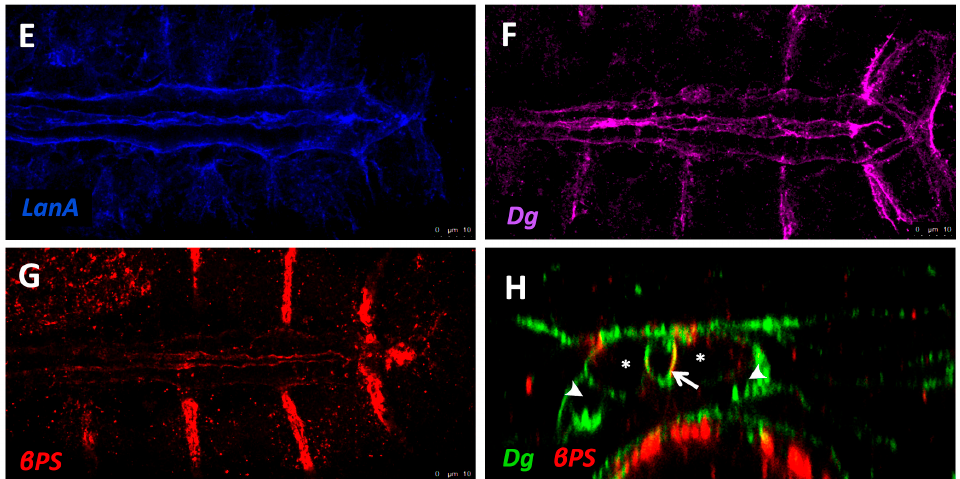
Figure 3. Localisation of ECM proteins and receptors in the embryonic Drosophila heart. ( A ) Cross-sectional impression of a stage 17 embryonic dorsal vessel with flanking PCs. The transmembrane receptors β PS-Integrin ( β PS) and Dystroglycan (Dg) are present along the cardioblast surface, but are concentrated at the luminal domain. Dg is excluded from the junctional domain. Laminin A (LanA) is present ubiquitously. Viking Collagen-IV (Vkg) localises to the basal lamina and is expressed within the heart lumen. Pericardin (Prc) is absent from the lumen. Dorsal at top. CB: cardioblast; JD: junctional domain; L: lumen; PC: pericardial cell; ( B ) A portion of the embryonic dorsal vessel in coronal view (frontal plane), illustrating CBs but not PCs. Alary muscles have not been included for simplicity; ( C–G ) Distribution of ECM proteins and receptors in stage 17 embryos. Anterior on left. ( C ) Vkg is expressed along the basal lamina of cardiac cells, localised to the luminal and abluminal surfaces. The striated lines running parallel the heart tube is an eggshell artefact; ( D ) Prc forms bundles localised to the abluminal surface of the heart tube, and envelopes the PCs; ( E ) LanA is expressed along the luminal and abluminal cardiac cell surface and within muscle costameres; ( F ) Dg localises to the apical CB surfaces, and to costameres; ( G ) β PS-Integrin is expressed primarily along the CB apical and luminal surfaces, and to a lesser extent along the basal surface; ( H ) Cross-sectional distribution of Dg and β PS-Integrin in a stage 17 embryo. Dg is strongly expressed along the CB luminal surface, and is also present on the abluminal surface, with weak ventral expression. Integrin is strongly expressed along the CB luminal surface, and weakly expressed along the abluminal surface. Dorsal at top. Asterisks label CBs; arrows label the heart lumen; arrowheads label PCs.